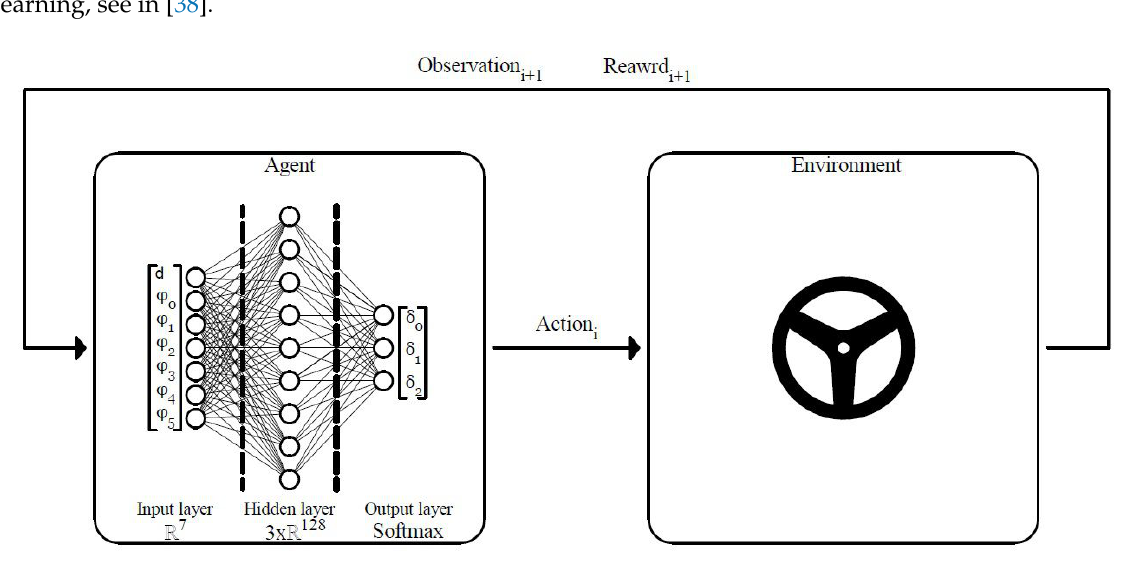
Figure 4. The RL training